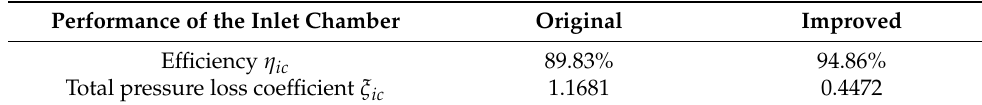
Table 5. Performance comparison of the original and improved radial inlet chambers.